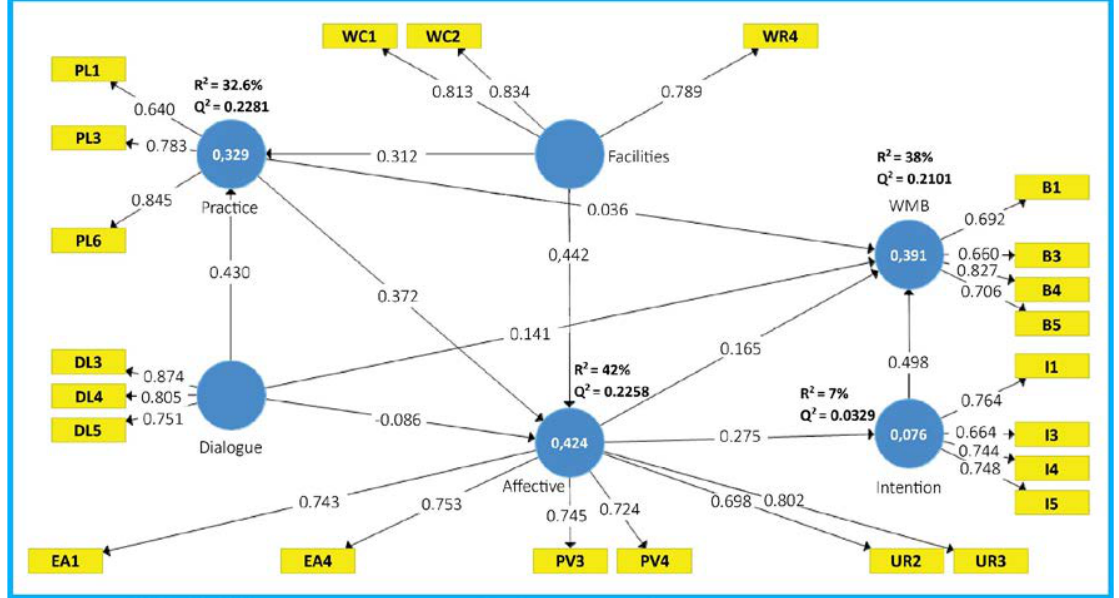
Fig. 7: Path coefficient significance of the proposed model